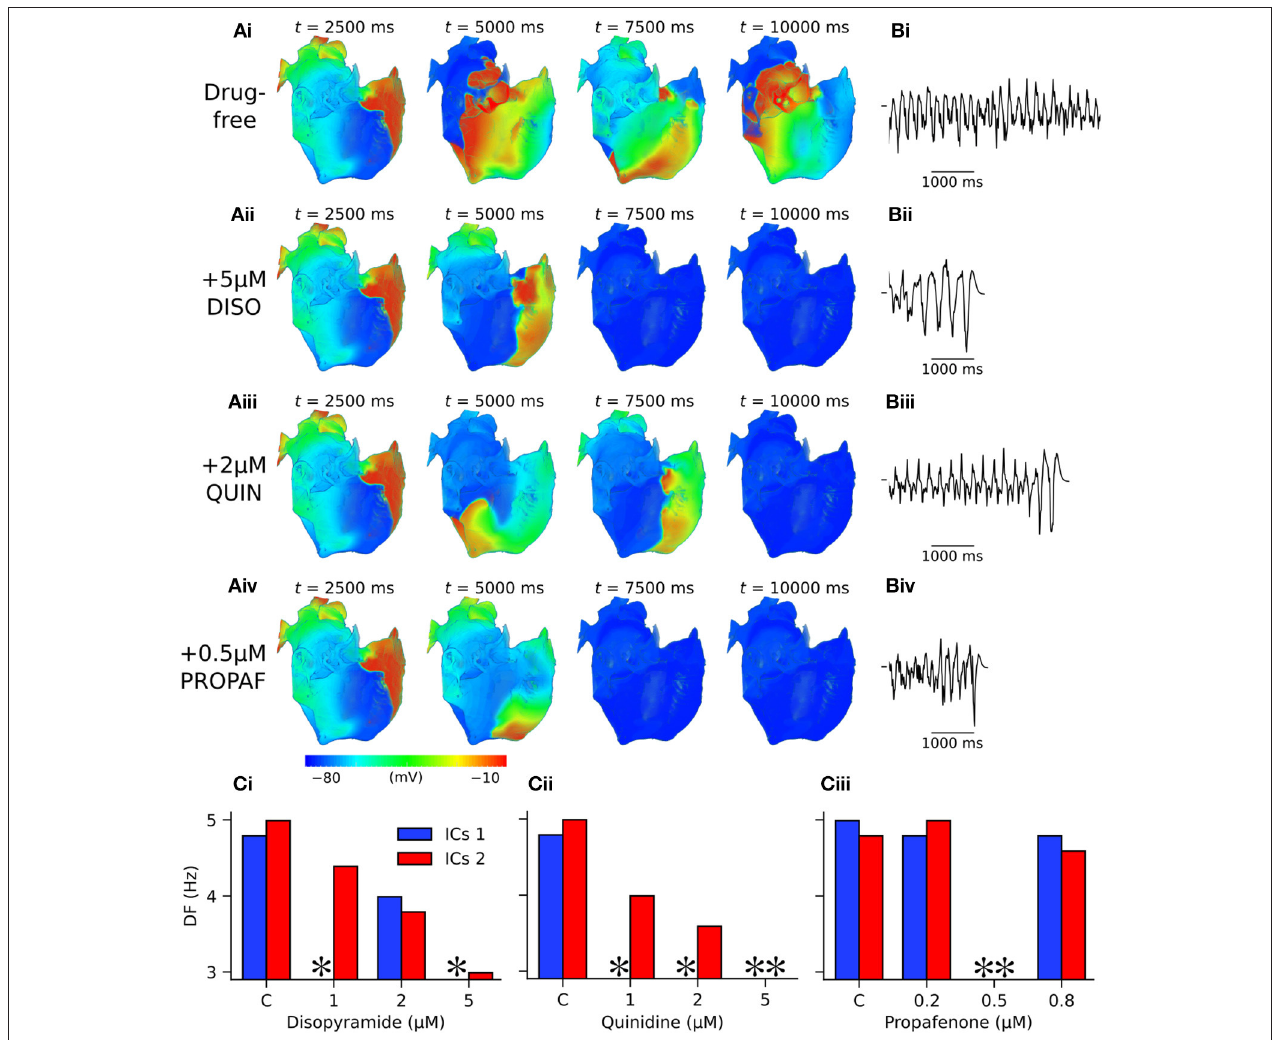
FIGURE 7 | Arrhythmia termination in 3D anatomical human atria by representative concentrations of disopyramide, propafenone, and quinidine under SQT1 mutation conditions. (A) Snapshots of re-entrant scroll waves in a clockwise configuration (viewed from RA posterior wall) at various time points after initiation of a scroll wave in the 3D anatomical human atrial model under (i) drug-free WT-N588K conditions, and upon application of (ii) 5 µ M disopyramide (DISO), (iii) 0.5 µ M propafenone (PROPAF), and (iv) 2 µ M quinidine (QUIN) conditions, with (B) corresponding pseudo ECG recorded during the final 5.0s. In pharmacological simulation drugs were applied at t = 2,500ms. (C) Barcharts summarizing DF upon application of various concentrations of (i) DISO, (ii) PROPAF, and (iii) QUIN for clockwise and anti-clockwise initial conditions (ICs 1 and ICs 2, respectively). * denotes simulations in which DF was not calculated due to occurrence of re-entry